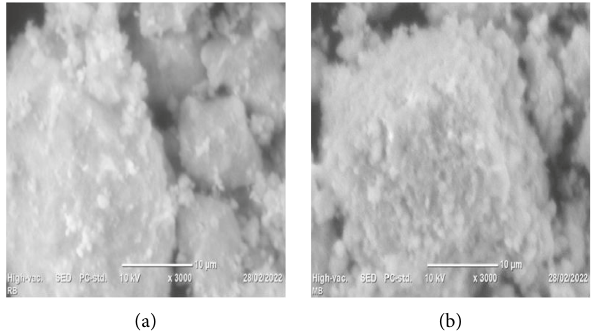
Figure 4: SEM images of (a) bentonite (BNa) and (b) nanocomposite adsorbent (BMNC).